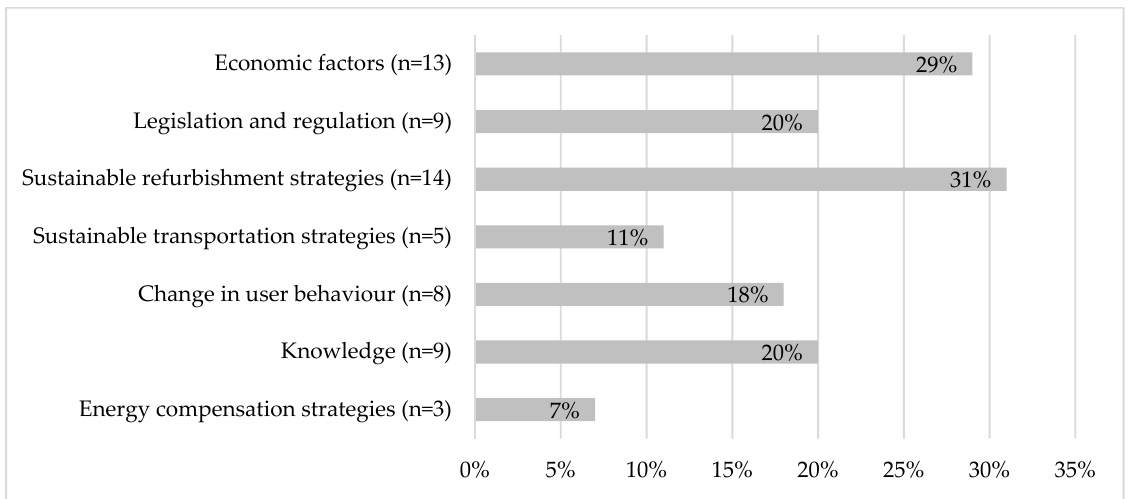
Figure 3. Percentage (and number) of interviewees mentioning each of the di ff erent enablers of climate change mitigation. ( n is the number of interviewees mentioning the